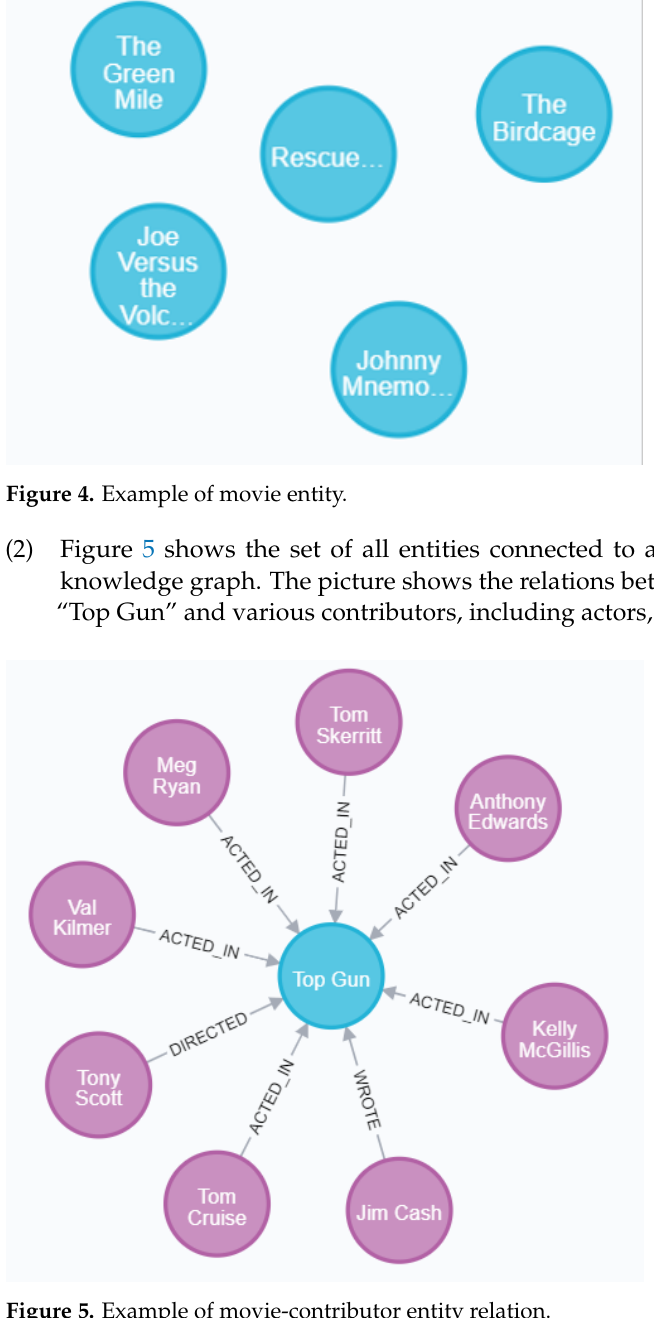
Figure 5. Example of movie-contributor entity